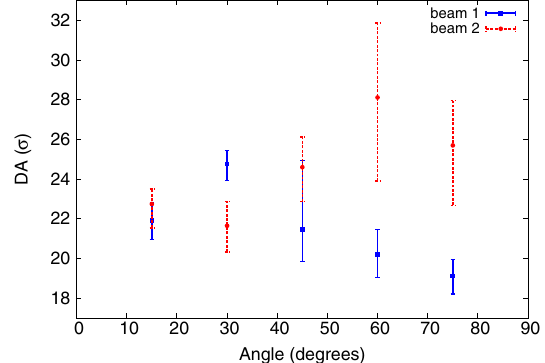
FIG. 13. Synchrotron radiation power given as a function of L (cid:1) and the beam separation in Q1. The black symbols show the cases for scaling the LHeC CDR, the pink and green symbols (almost overlaid in the image) show the minimum beam separation for bunch spacings 25 and 50 ns respectively.